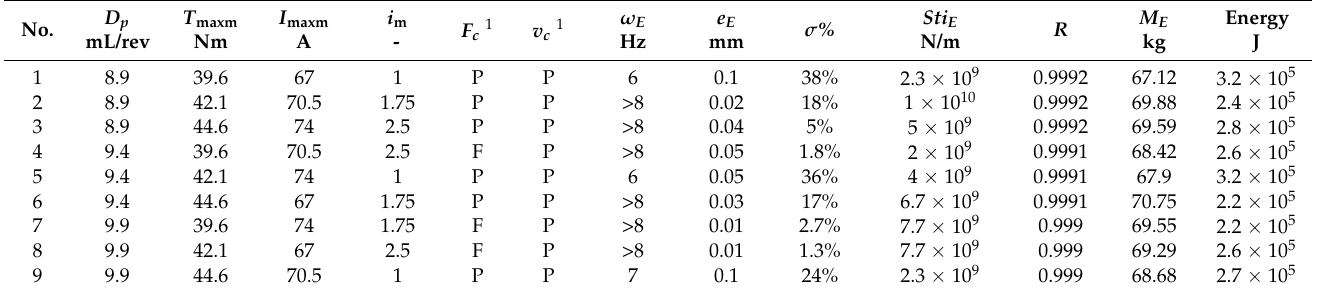
Table 4. The L 9 (3 4 ) orthogonal array of the optimization variables and the corresponding